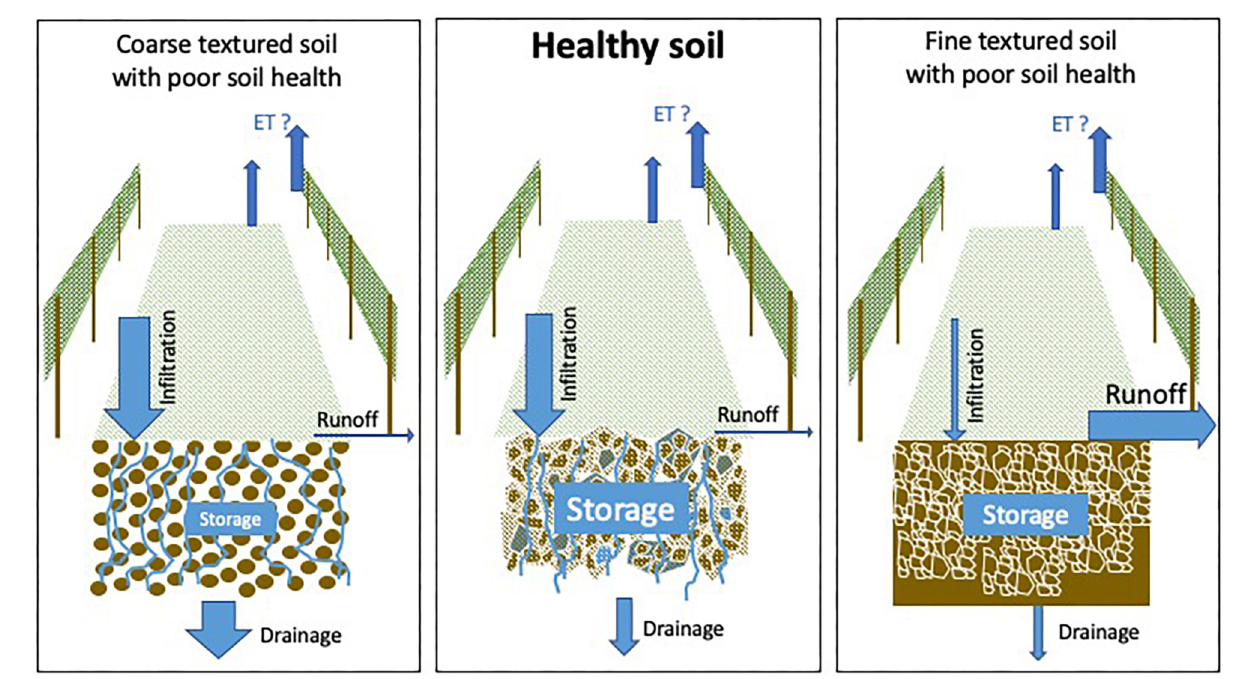
FIGURE 5 | Vineyard water fluxes from a soil perspective in coarse textured soil with poor soil health (left), a healthy soil (middle), and a fine textured soil with poor soil health